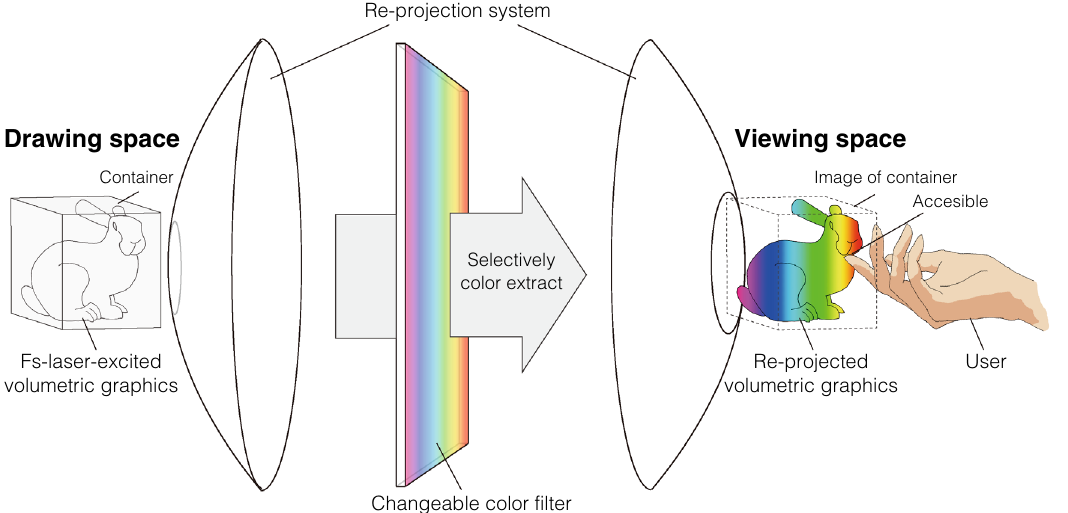
Figure 1. Concept of drawing space separation (DSS). The drawing space is separated from the viewing space by a re-projection system. DSS allows the arrangement of a mechanism that can change the transmitted color of light and displays a multicolor volumetric graphics by selectively extracting colors from femtosecond-laser- excited emission points. The arrangement of materials that assist in emission generation in the drawing space is possible without interfering with accessibility between the user and graphics. This figure was created using Adobe Illustrator 2021 version 25.4.1 (https:// www. adobe. com/ produ cts/ illus trator.